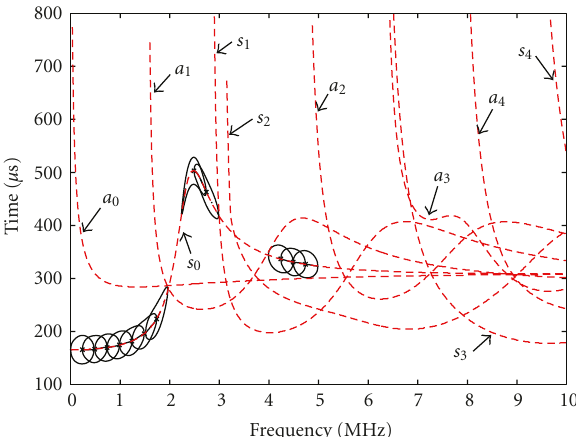
Figure 1: CT basis functions adjusted to the s 0 -mode using 5th- order time shear. The dispersion curves are the solution of the Rayleigh-Lamb equations (17) for an aluminum 3003 plate of thickness 0.99 mm and source-receiver distance of 90